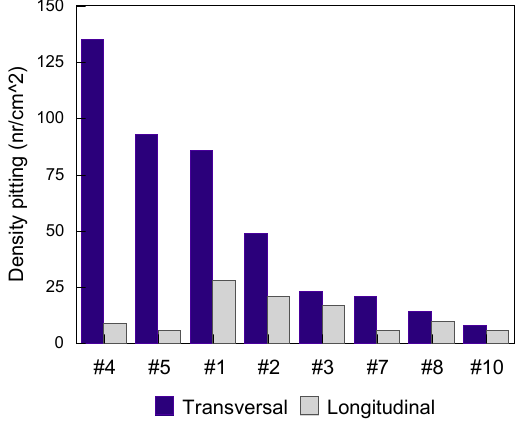
Figure 8. Pitting test results of the transverse and longitudinal surfaces for various grades of steels (0.5 M NaCl test medium at 37 °C for 26 days).